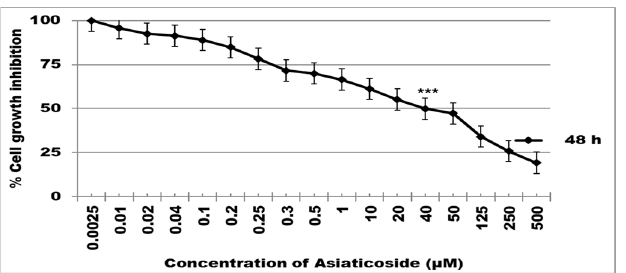
Figure 1. The effect of asiaticoside on cell viability. MCF-7 cells were incubated at 37 °C with several concentrations of asiaticoside for 48 h. The cytotoxicity of asiaticoside was measured using an MTT assay. *** p < 0.0001 one-way ANOVA. Values are mean ± SD from six independent experiments.